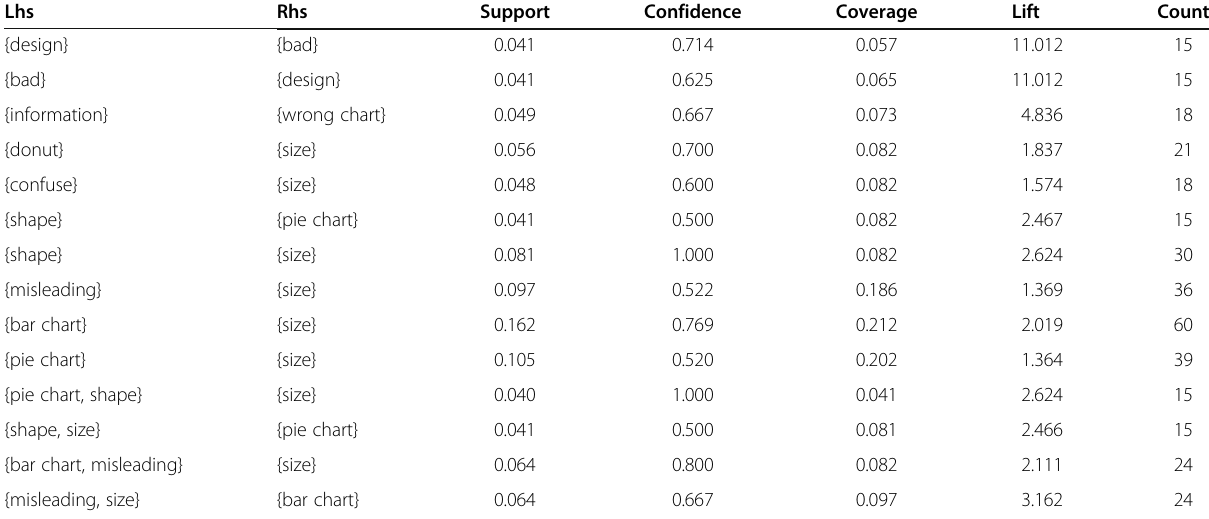
Table 2 Association rules mining in the figures ’ descriptions Lhs Rhs